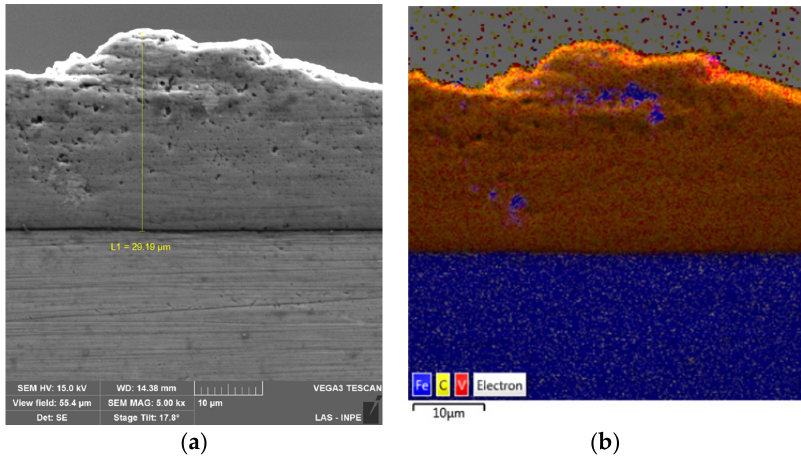
Figure 3. The TCVC cross ‐ section after 7 h process time: ( a ) thickness; ( b ) mapping.